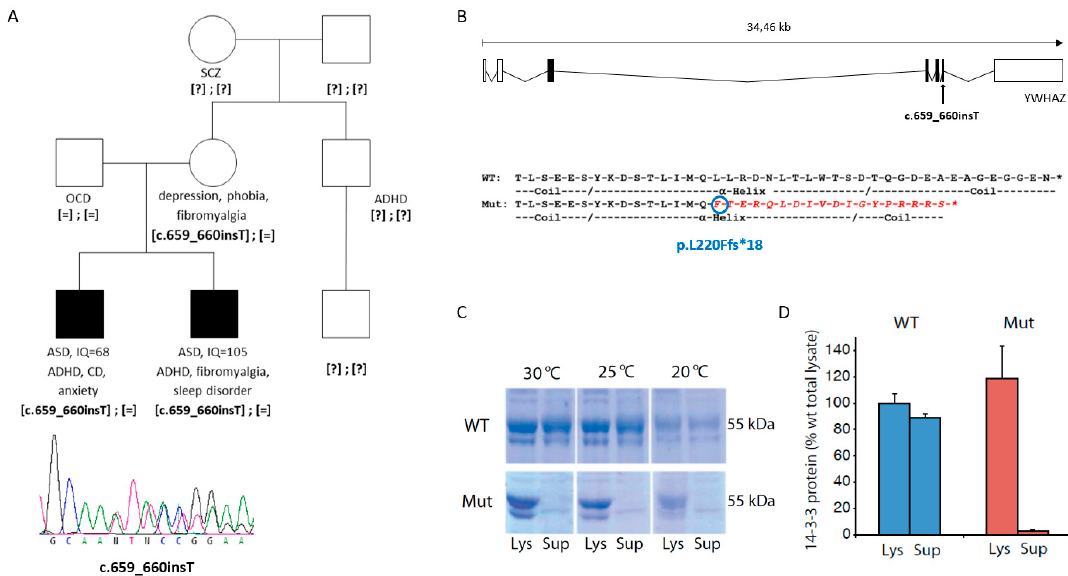
Figure 1. Mutation identified in YWHAZ in two siblings with ASD. ( A ) Pedigree of the family carrying the c.659-660insT mutation in YWHAZ and below the Sanger sequence of the truncating variant. Abbreviations: ADHD, attention-deficit hyperactivity disorder; ASD, autism spectrum disorder; CD, conduct disorder; IQ, intelligence quotient; OCD, obsessive-compulsive disorder; SCZ, schizophrenia. [=], wild-type allele; [?], unknown genotype. ( B ) Location of the mutation in the YWHAZ gene, and comparison of the last amino acids of the wild-type (WT) and mutant (Mut) 14-3-3 ζ protein, showing in red the amino acids that diverge in the mutant protein. ( C ) Coomassie stained sodium dodecyl sulphate-polyacrylamide gel electrophoresis (SDS-PAGE) of glutathione-S-transferase (GST)-14-3-3 ζ (WT and mutant) expressed in E. coli strain at different temperatures. Aliquots of the bacteria were lysed, and the amount of soluble protein was assessed by comparing total lysate (Lys) to supernatant after centrifugation of the lysate (Sup) for wild-type 14-3-3 ζ (WT) and mutant 14-3-3 ζ (Mut). ( D ) Quantification of solubility by measuring the major GST-14-3-3 band (55 kDa) for WT and Mut expressed at 30 °C. Data presented as means and error bars denote the standard deviation ( n = 3; p = 1.7× 10 − 3 for Mut Lys vs. Mut Sup; p = 1.4 × 10 − 4 for WT Sup vs. Mut Sup; t-test, two sided).